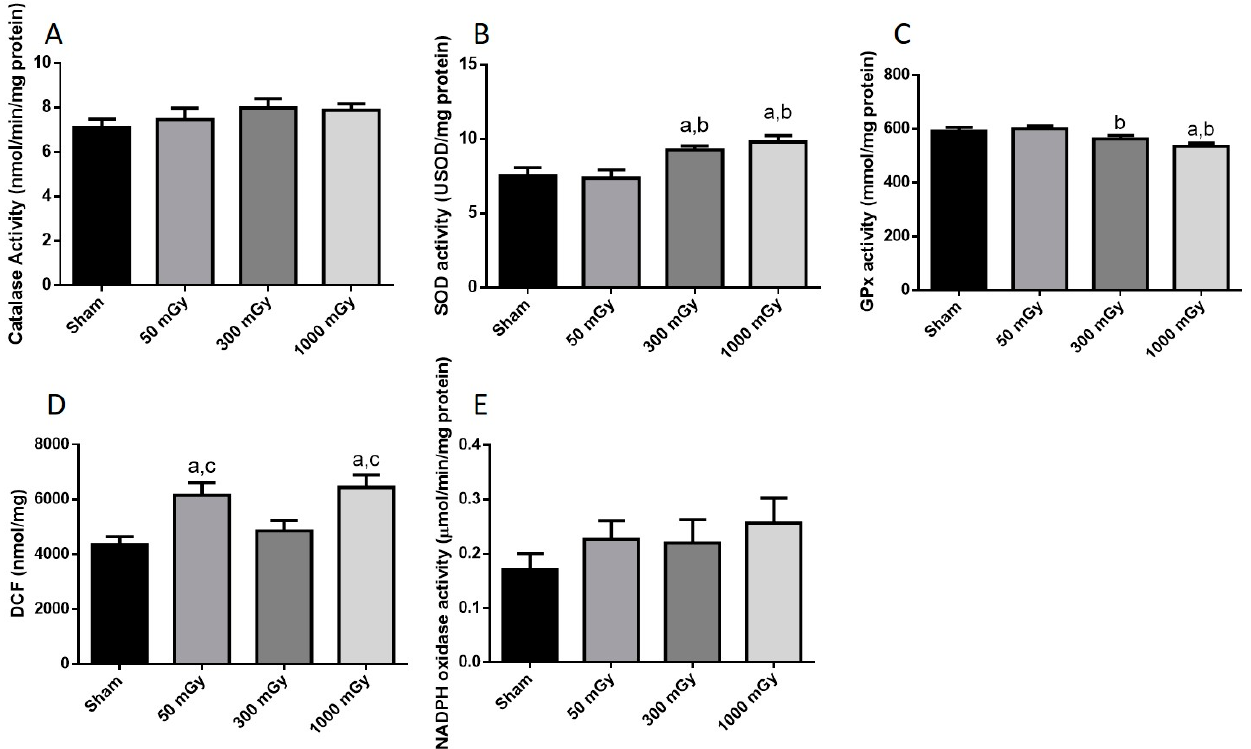
Figure 8. Antioxidant and oxidative stress status. Enzyme activity of the antioxidants ( A ) catalase, ( B ) superoxide dismutase (SOD), and ( C ) glutathione peroxidase (GPx); and ( D ) total reactive oxygen species expressed as mmol/mg of DCF; and ( E ) NADPH oxidase activity in female offspring heart tissues. Data are presented as a mean ± SEM. a—is significantly different than control, b—is significantly different than 50 mGy, and c—is significantly different from 300 mGy, p ≤ 0.05. n = 11–19 except ( E ) where n = 8–9 per group. Table 2. Cardiac reduced (GSH) and oxidized glutathione (GSSG) levels, and redox ratio (GSH/GSSG) in male and female offspring after being exposed to 50 mGy, 300 mGy, or 1000 mGy gamma radiation in utero. Sham 50 mGy 300 mGy 1000 mGy Sham 50 mGy 106.2 ± 4.15 Male GSH ( µ